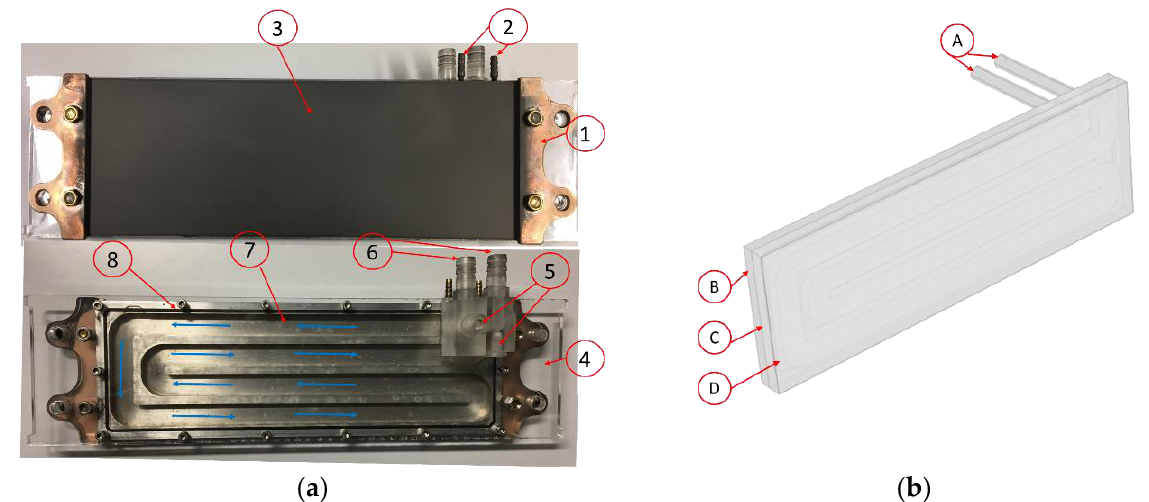
Figure 10. ( a ) Stator test section (top: 1—copper connectors, 2—tappings for pressure meas., 3—blackened Inconel ® surface, bottom: 4—acrylic glass, 5—tappings for temp. meas., 6—in- and outlet, 7—cooling duct, 8—aluminum base); ( b ) flat stator test section FEM-model based on CAD data (A—abstracted and elongated inlet and outlet for stable convergence, B—acrylic glass, C—aluminum base with coolant ducts, D—100 µm Inconel ® sheet).